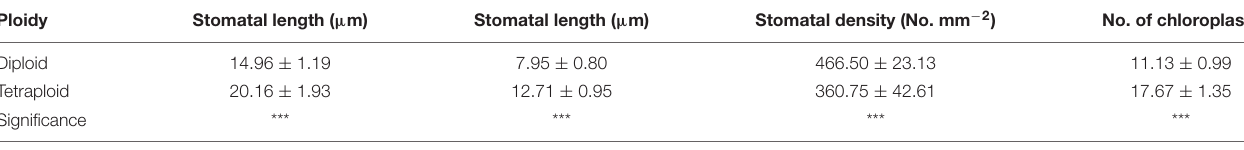
TABLE 6 | Stomatal characteristics of tetraploid and diploid Eucalyptus urophylla .